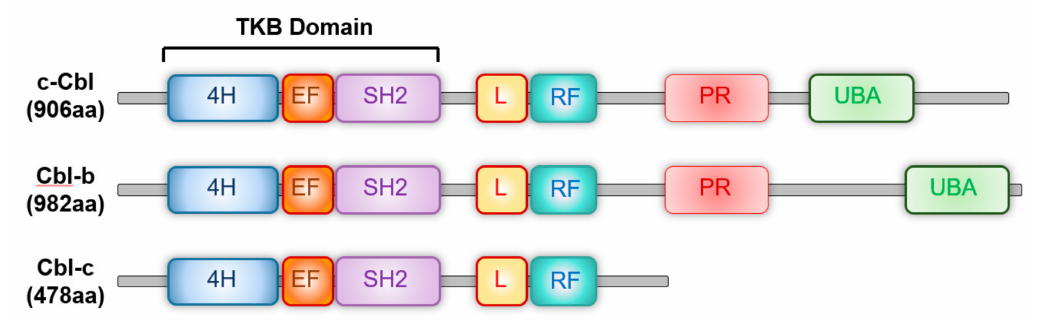
Figure 1. The primary structure and domain organization of human Casitas b-lineage lymphoma family proteins. c-Cbl, Cbl-b and Cbl-c proteins contain highly conserved tyrosine kinase-binding (TKB), linker (L), RING finger (RF) and proline-rich (PR) domains. 4H: Four-helix bundle; EF: EF hand, SH2: Src-homology 2; UBA: Ubiquitin-associated